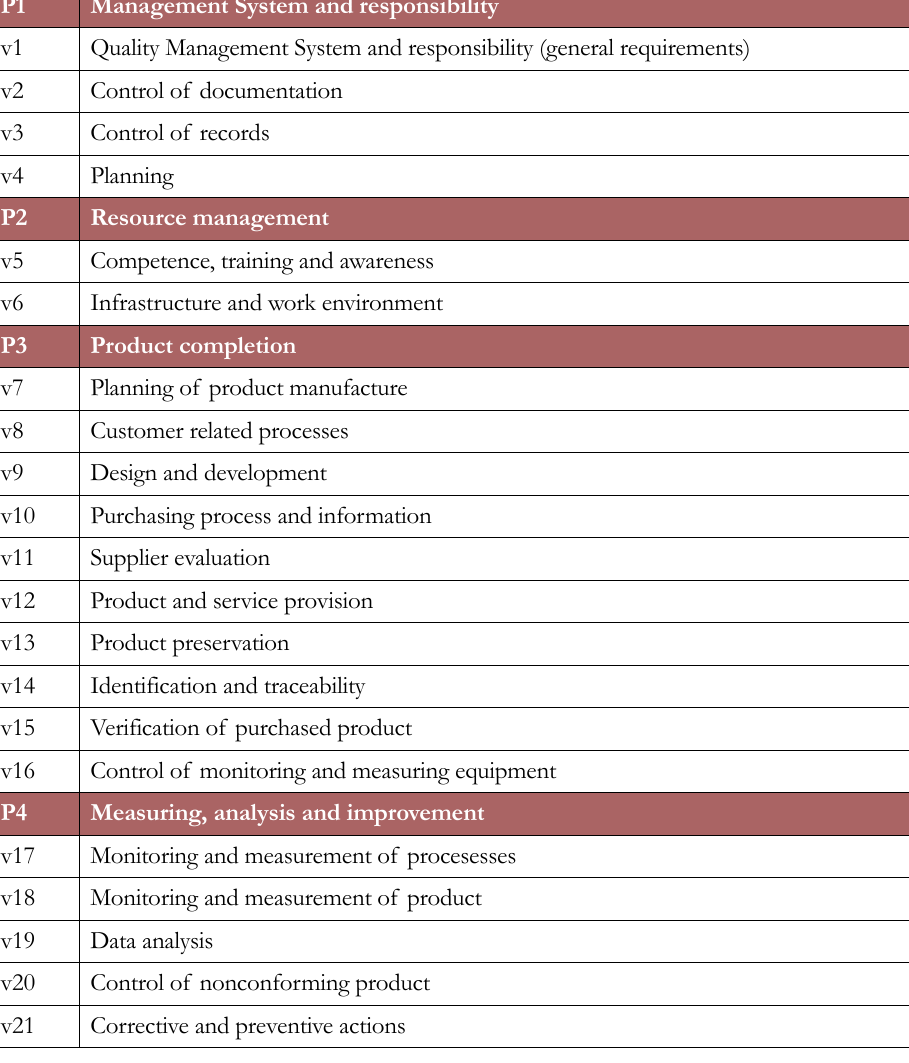
Table 1. Audited items on supplier site